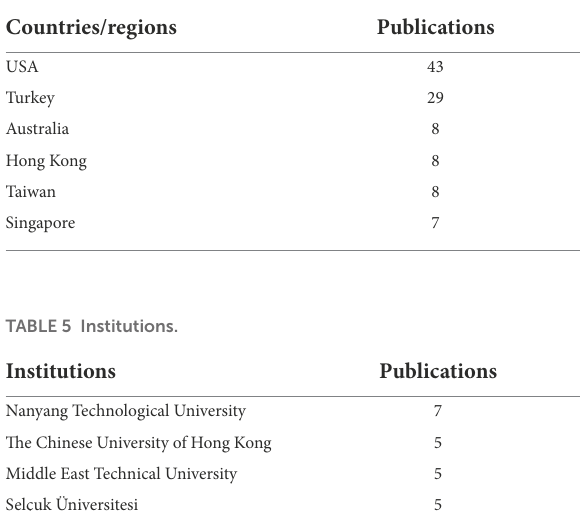
TABLE 4 Countries/regions.